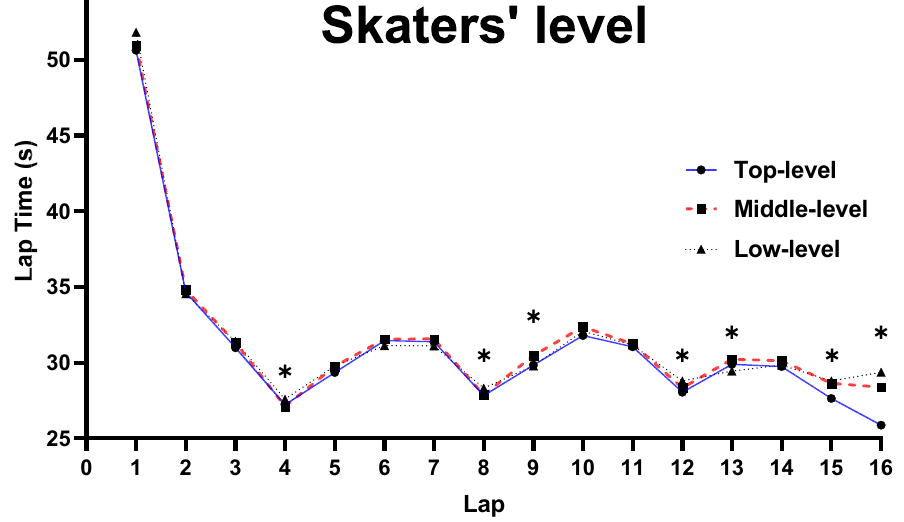
Figure 4. Comparison of lap time spent for SL. Note: * marked values were significant when p ≤